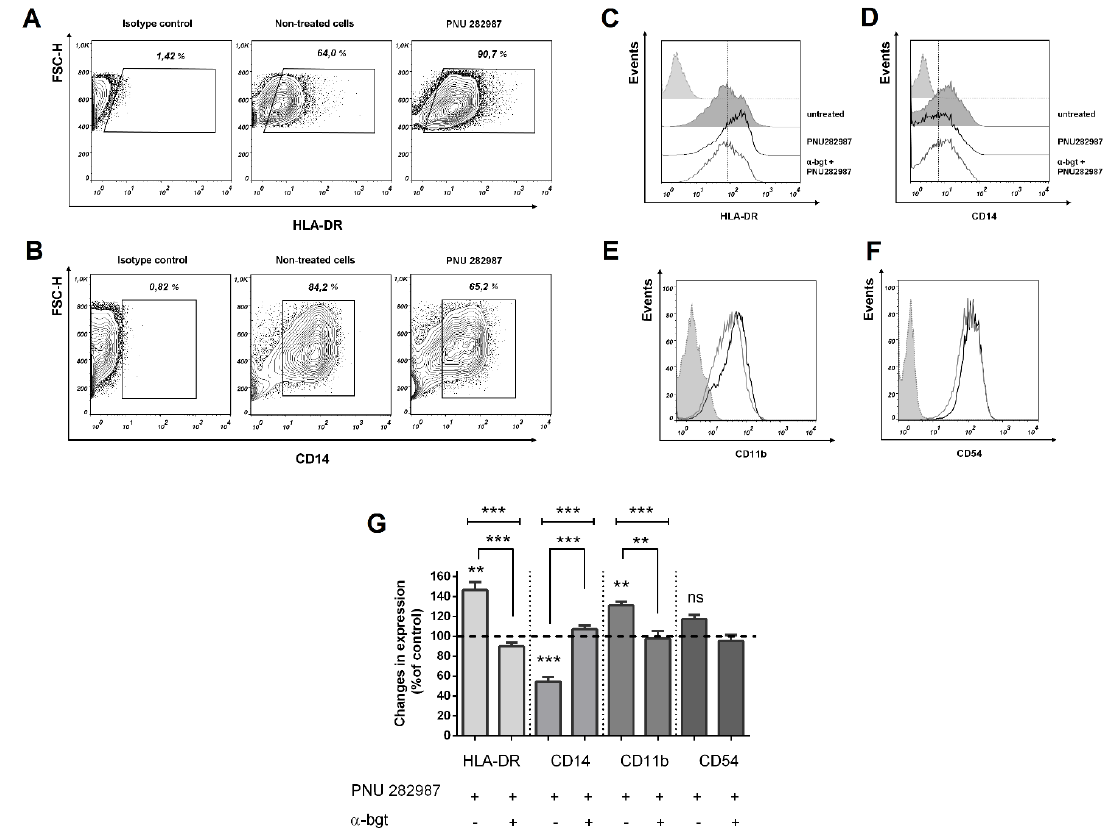
Figure 6. Representative expression profile and effect of PNU 282,987 on the expression of HLA-DR, CD14, CD54, and CD11b in the MDMs. The expression levels ( A ) of HLA-DR and ( B ) CD14 on the PNU 282,987 treated and untreated MDMs are shown. These cells were treated with PNU 282,987 or PNU 282,987 + α -bgt for 48 h and analyzed by Fluorescence-Activated Cell Sorting (FACS). PNU 282,987 induced an increase in the expression ( C) of HLA-DR molecules, ( E ) CD11b, ( F ) CD54, and decreased the expression ( D ) of CD14; the effect of PNU 282,987 is blocked by the α 7 receptor antagonist α -bgt. Histograms: gray dashed—isotype control; gray line—cells control; black line—PNU 282,987 treated cells. ( G ) Changes in the expression level of membrane proteins involved in inflammation on MDMs treated with PNU 282,987. The bars are expressed as mean ± SEM. The results were obtained in three experiments on MDMs from three different donors. One-way ANOVA tests with Turkey post hoc test: PNU 282,987 vs. non-treated cells and PNU 282,987 vs. PNU 282,987 + α -bgt: ** p ≤ 0.01, *** p < 0.001, ns p > 0.05.